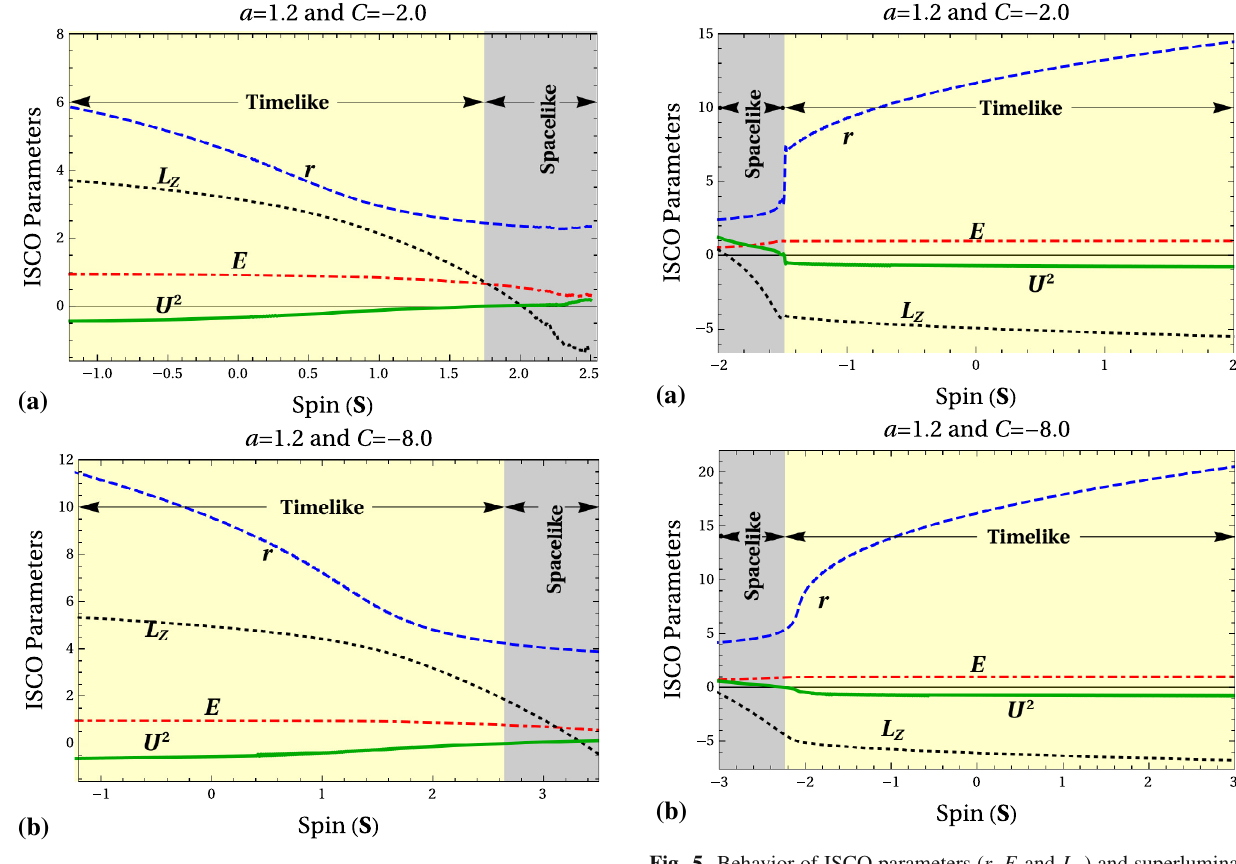
Fig. 4 Behavior of ISCO parameters ( r , E and L z ) and superluminal constraint ( U 2 ) as a function of spin ( S ) for the spinning test particle in the rotating braneworld BH for corotating case ( J z > 0). Here also, we keep the mass parameter M equals to unity